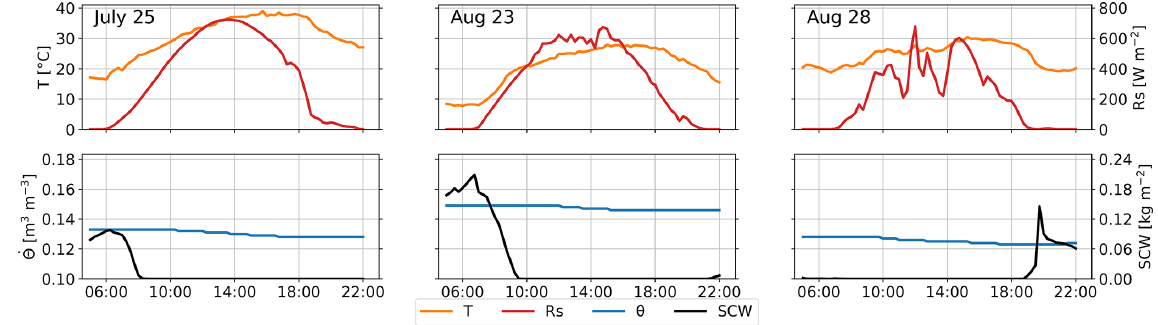
Figure 7. Environmental conditions on the sampling days of 25 July and 23 and 28 August (2019). The upper row shows air temperature ( T ) and solar radiation ( R s ), and the lower row shows root zone soil moisture ( θ ) and surface canopy water